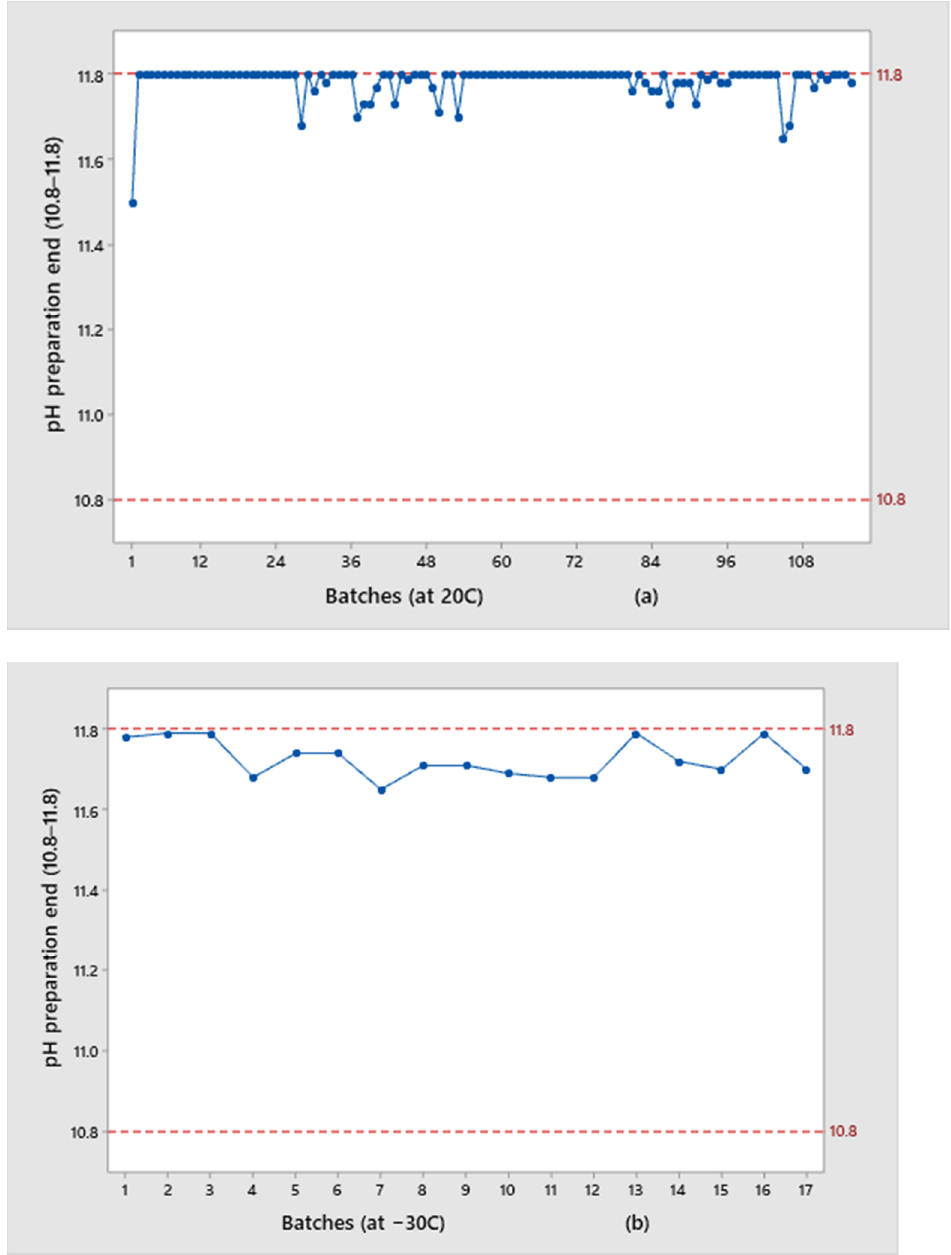
Figure 3. Comparison of pH values of the bulk solution at the end of preparation for the batches: ( a ) Kept at 20 °C; ( b ) Kept at −30 °C .